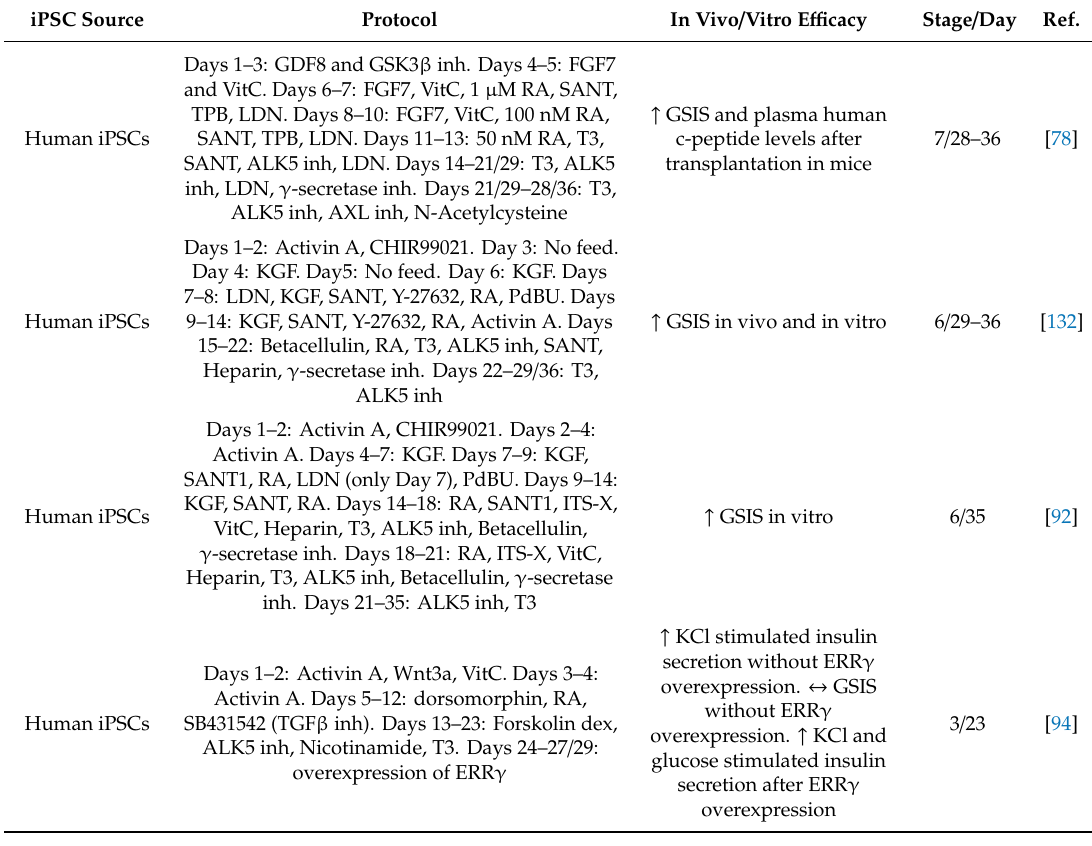
Table 1. Overview of protocols used for di ff erentiation of pancreatic β -like cells from human iPSCs. iPSC Source Protocol In Vivo / Vitro E ffi cacy Stage / Day